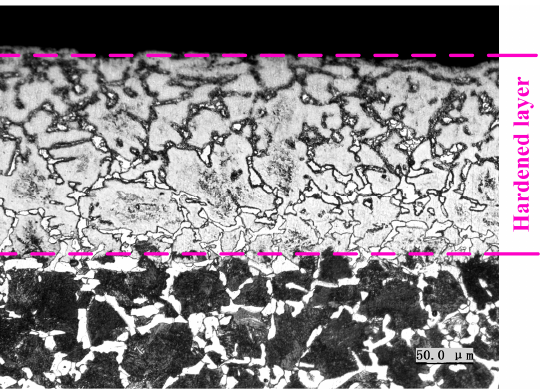
Figure 10. The microstructure distribution after grind-hardening ( a e = 350 μ m, v s = 9 m/min, v s = 26.4 m/s). v s = 26.4